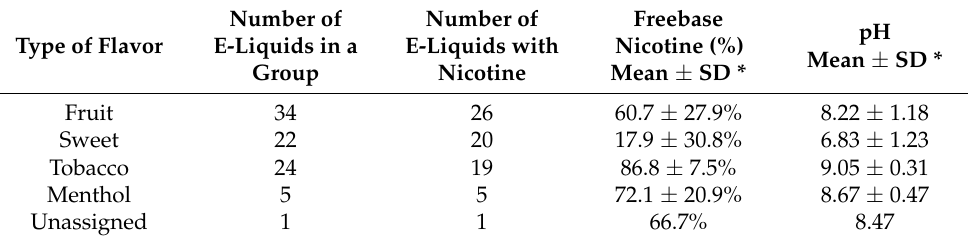
Table 3. Mean freebase nicotine content of different nicotine labeled refill solutions.